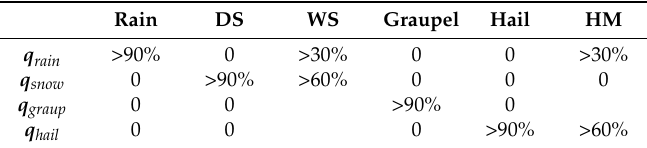
Table 1. Hydrometeor Classification Algorithms (HCA) classes determined by values of q obtained from the WRF model. The percentages are the mixing ratio quantity of a given hydrometers with respect to the sum of q of all classes. DS stand for dry snow , WS for wet snow , and HM for hail mix . For instance, the rain class is defined when the percentage of q rain is greater than 90%, while WS class is defined when q rain is greater than 30% and q snow is greater than 60%. Rain DS WS Graupel Hail